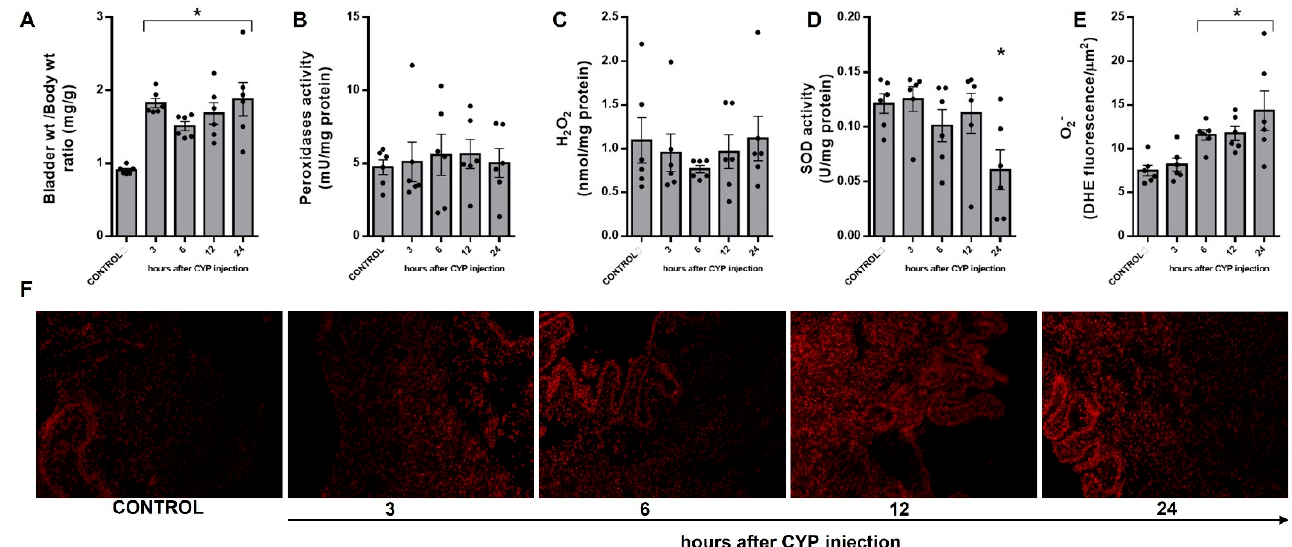
Figure 1. Temporal changes in the female mouse urinary bladder after cyclophosphamide (CYP; 300 mg/Kg, ip) injection in relation to the control group (saline). ( A ) Bladder weight/total body weight ratio. Changes in peroxidases ( B ), hydrogen peroxide (H 2 O 2 ; ( C )) levels, and superoxide dismutase (SOD; ( D )) activity were measured by colorimetric assays. Superoxide anion (O 2 − ) levels were determined by a dihydroethidium (DHE) fluorescence assay ( E , F ). The fluorescence intensity was quantified using ImageJ. Summary data (mean ± SEM) represent n = 6 for each group/time point. Significance was tested by one-way ANOVA followed by multiple comparisons by Tukey’s post-hoc test. * p < 0.05 vs. the CONTROL.